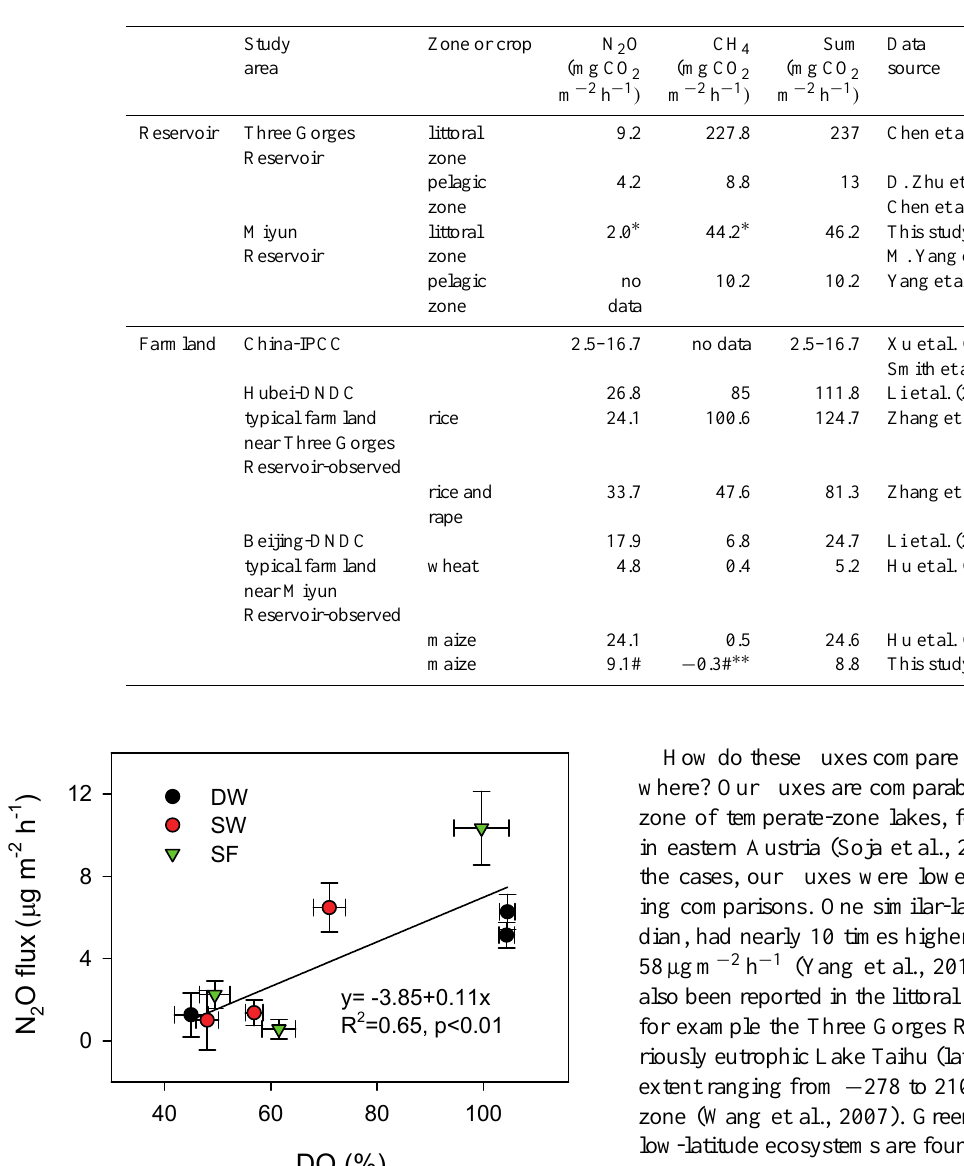
Table 4. Comparison of N 2 O and CH 4 emission from reservoir and farmland (both expressed as CO 2 equivalent, see text). Flux was transformed into CO 2 equivalent according to the global-warming potential (Stocker et al., 2013), i.e. 1 N 2 O = 298 CO 2 , 1 CH 4 = 34 CO 2 .